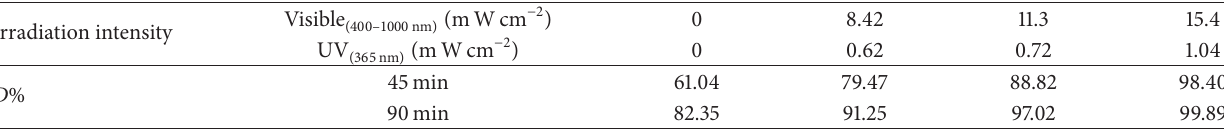
Table 1: Degradation of RR 195 under increasing light